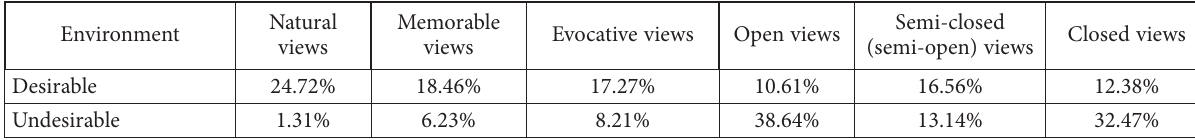
Table 2. People’s preferences for made environments (source: